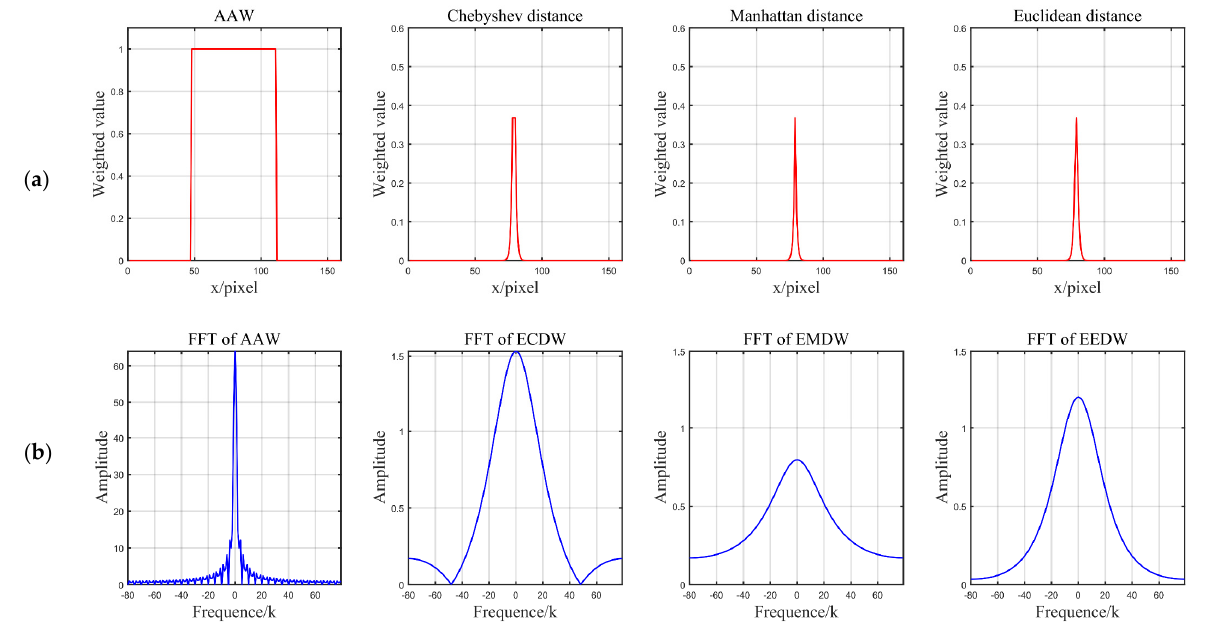
Figure 5. Plot of the weights of the AAW method, the exponential weighted distance ( a ) and the magnitude of the corresponding Fourier transformation ( b ) for the 32nd row of the 33rd slice. From left to right: AAW, exponential Chebyshev-distance-weighted (ECDW), exponential Manhattan-distance-weighted (EMDW), and exponential Euclidean-distance-weighted (EEDW). From the amplitude of FFT, we can find that the AAW method and ECDW retain some high-frequency information and cannot remove the grid-like artifacts to a greater degree.